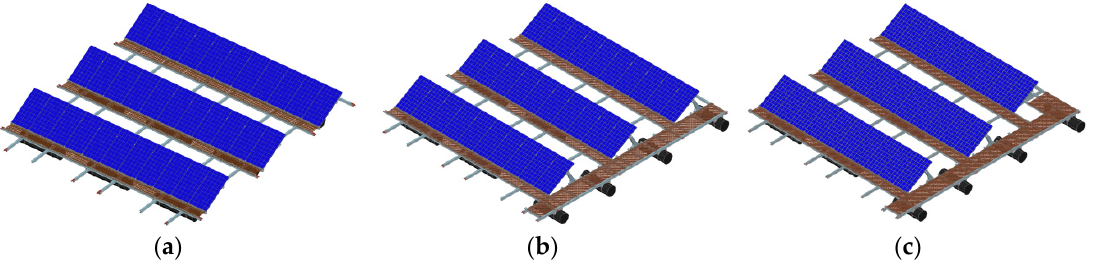
Figure 3. Unit structure ( a ) A type (basic mode); ( b ) B type (with foothold); ( c ) C type (to install electric device) [6].